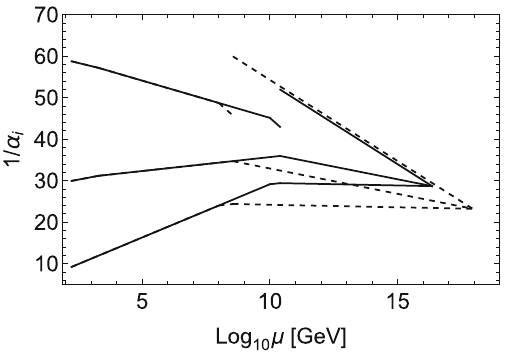
Fig. 1 RG running of gauge couplings for m D = 2 TeV. The solid (dashed) line denotes the result for m T = 10 5 ( 10 7 ) TeV. For both cases, the lines from top to bottom correspond to α 1 , 2 , 3 for μ < M PS and α R , L , 4 for M PS < μ < M GUT . For m T = 10 5 ( 10 7 ) TeV, we find M PS (cid:3) 3 . 5 × 10 8 ( 2 . 5 × 10 10 ) GeV and M GUT (cid:3) 8 . 8 × 10 17 ( 2 . 2 × 10 16 ) GeV